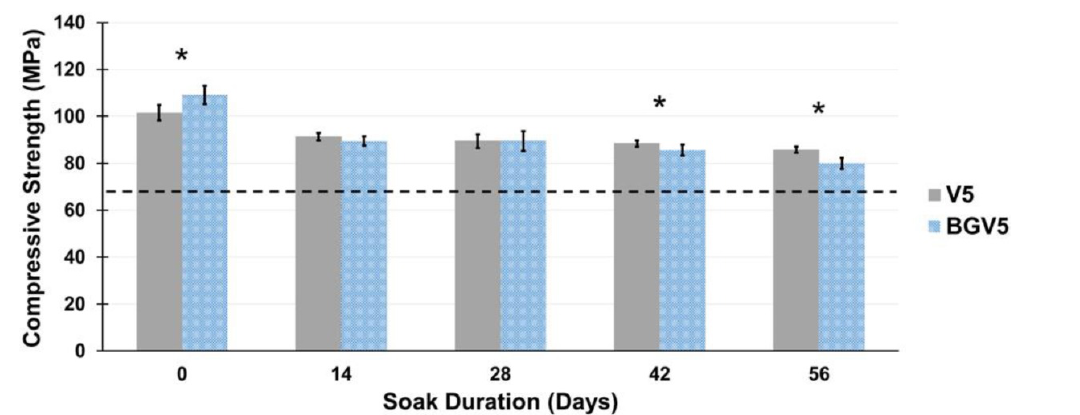
Figure 5. The compressive strengths of V1, BG, and BGV1 over time. An asterisk (*) over a bar represents a significant difference (p<0.05) between the groups (n=5) at the ends of the bar. Error bars represent ± one standard deviation. The dashed line indicates the 70 MPa threshold.